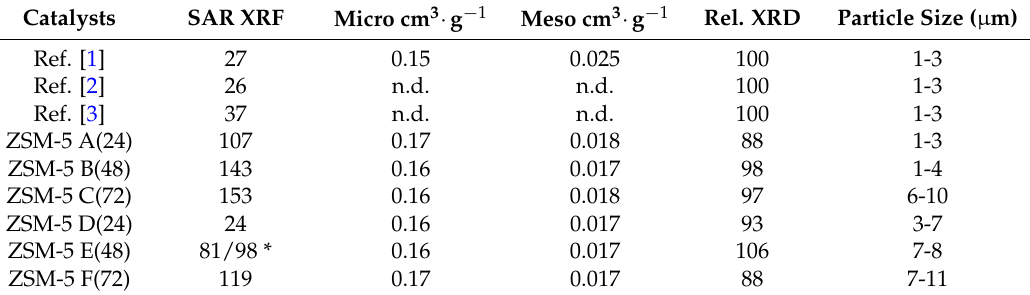
Table 2. ZSM-5 textural and structural